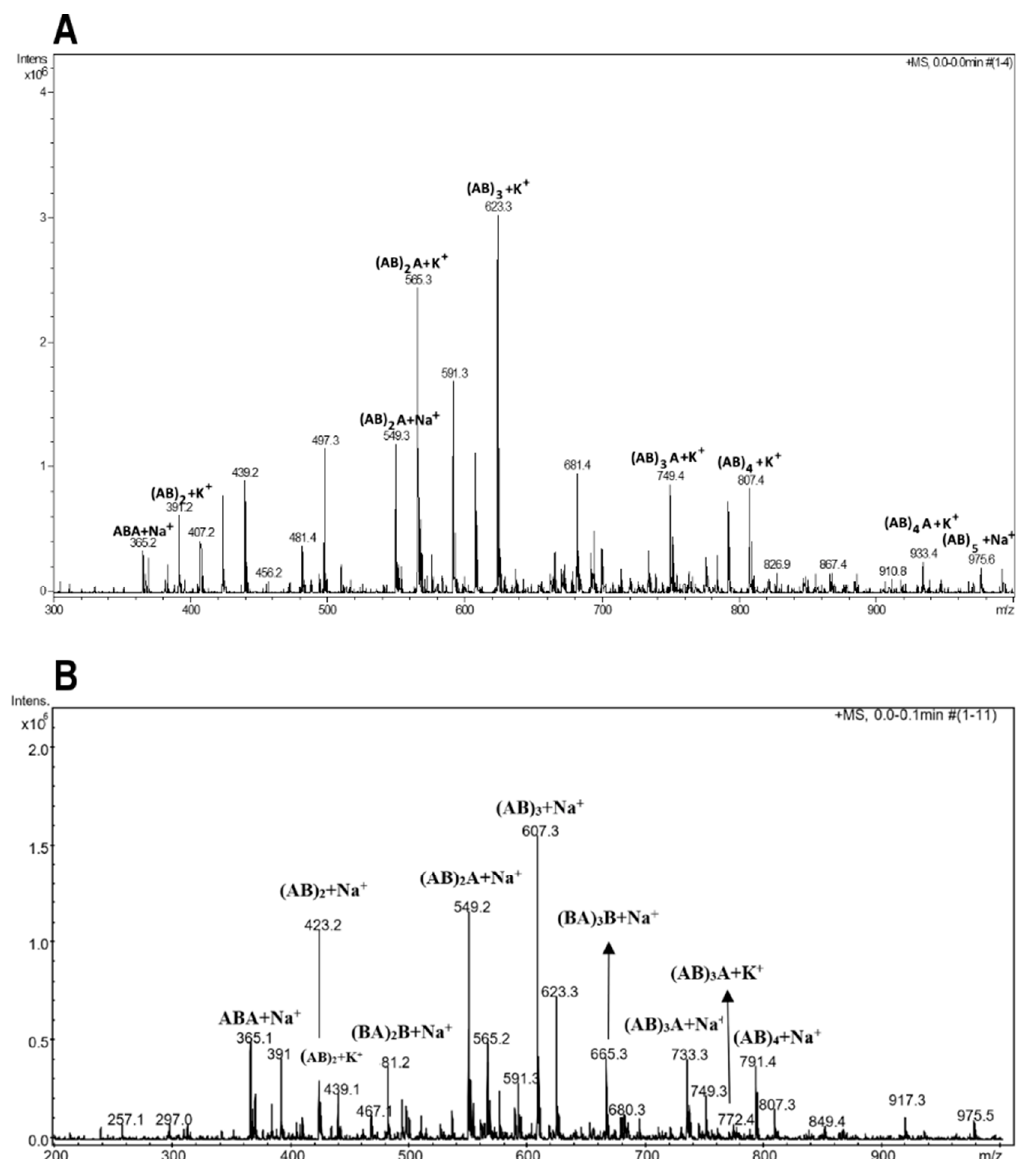
Figure 10. Electron Spry Ionization Mass Spectrometry (ESI-MS) positive ion mass spectra of the solvent-free enzymatic polycondensation products of dimethyl itaconate (DMI) with 1,4-butandiol (BDO) after 72 h. Top: Reaction catalyzed by CaLB on rice husk. Bottom: Reaction catalyzed by CaLB on EC-EP/S. A = BDO; B = DMI.